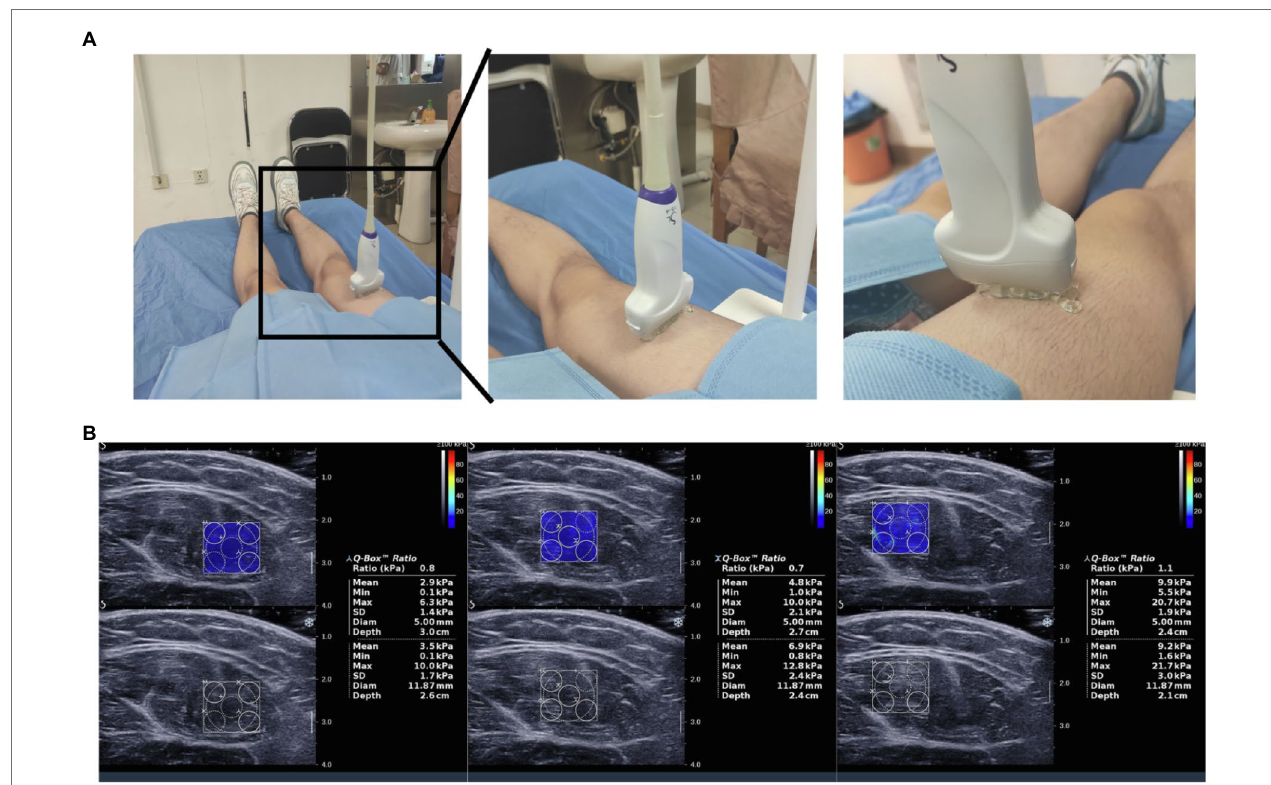
FIGURE 1 | Measurements of rectus femoris stiffness using shear wave elastography. (A) The process of shear wave ultrasound elastography assessment; (B) Shear wave ultrasound elastography (SWE) images of the rectus femoris are displayed together with the grayscale ultrasound images. After placing a box (frame) over the rectus femoris, a colored image appears, revealing blue and red areas on an elastogram. Dark blue areas correspond to soft tissues, whereas red areas correspond to stiff